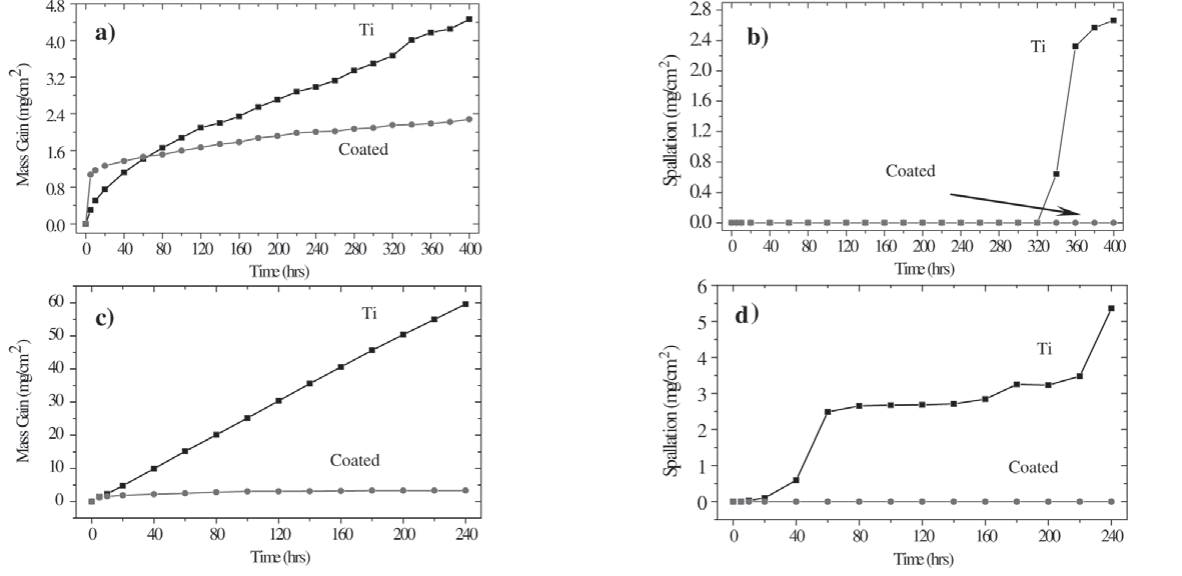
Figure 6 . Oxidation kinetics and scale spallation of Ti with and without composite coating: a-b) 700 °C; c-d) 800